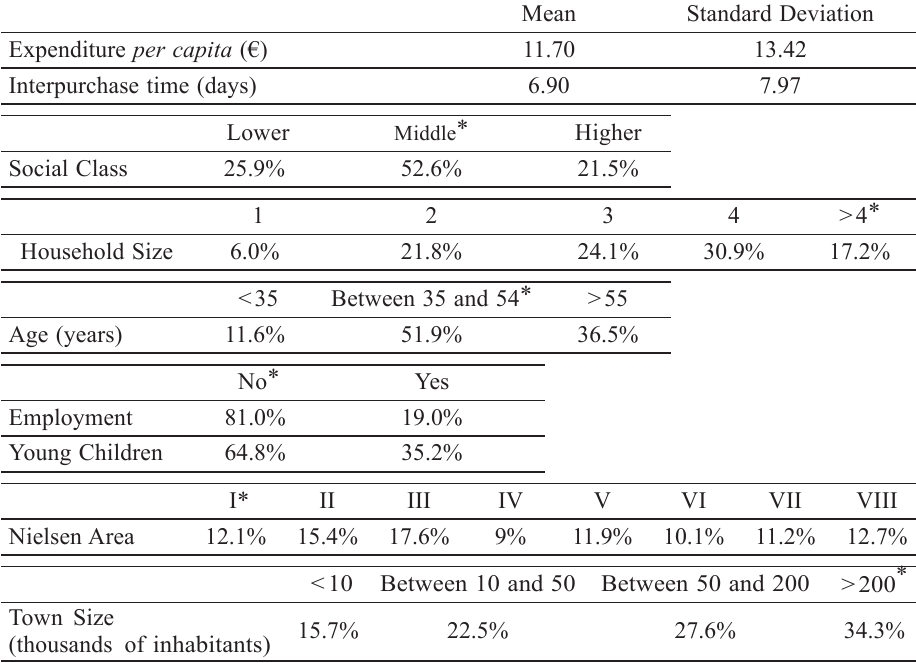
Table 4. Descriptive analysis of the independent variables